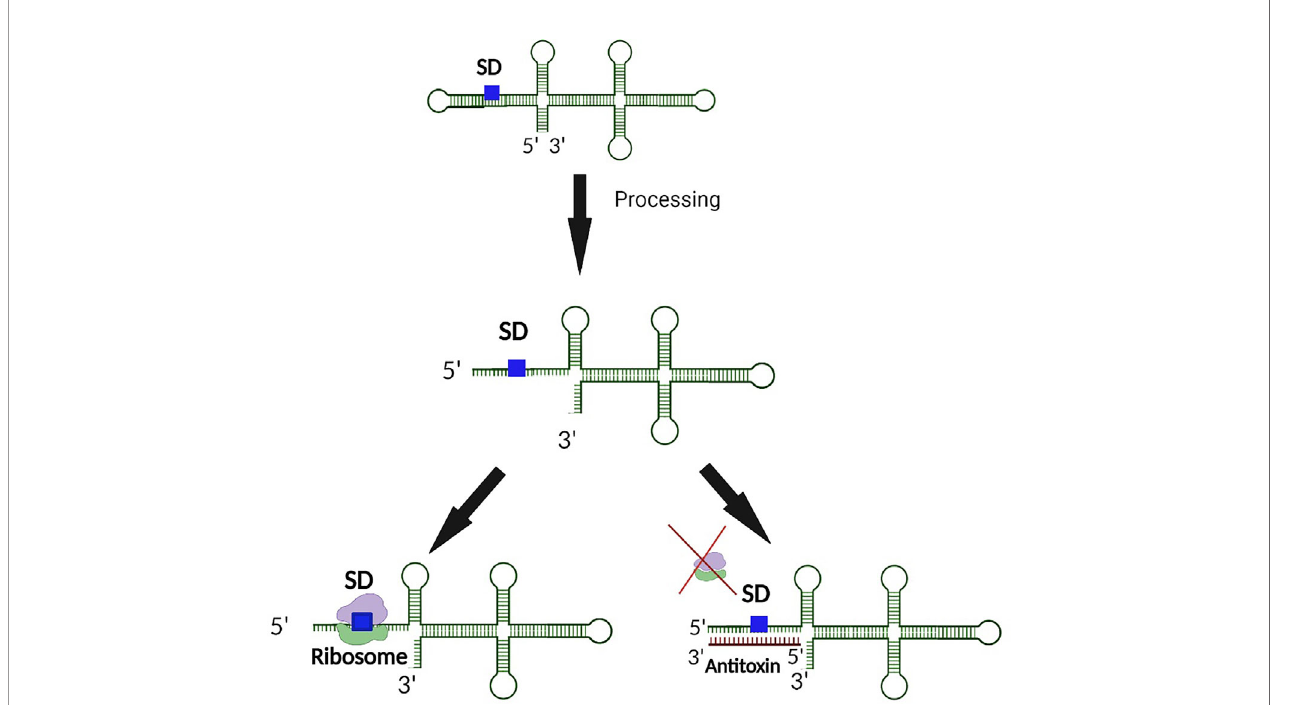
FIGURE 4 | 5 ’ end processing represents a second layer of regulation controlling the production of some Type I toxins. In the event an inhibitory secondary structure exists at the 5 ’ end of the toxin transcript, 5 ’ end processing exposes both the SD and antitoxin binding site. Upon exposure of the binding region, translation of the toxin is further regulated by an interaction between the antitoxin and the SD of the toxin transcript such that ribosomal binding is inhibited. Such dual regulation ensures minimal production of the Type I toxin when its activity would be deleterious to the bacterium.